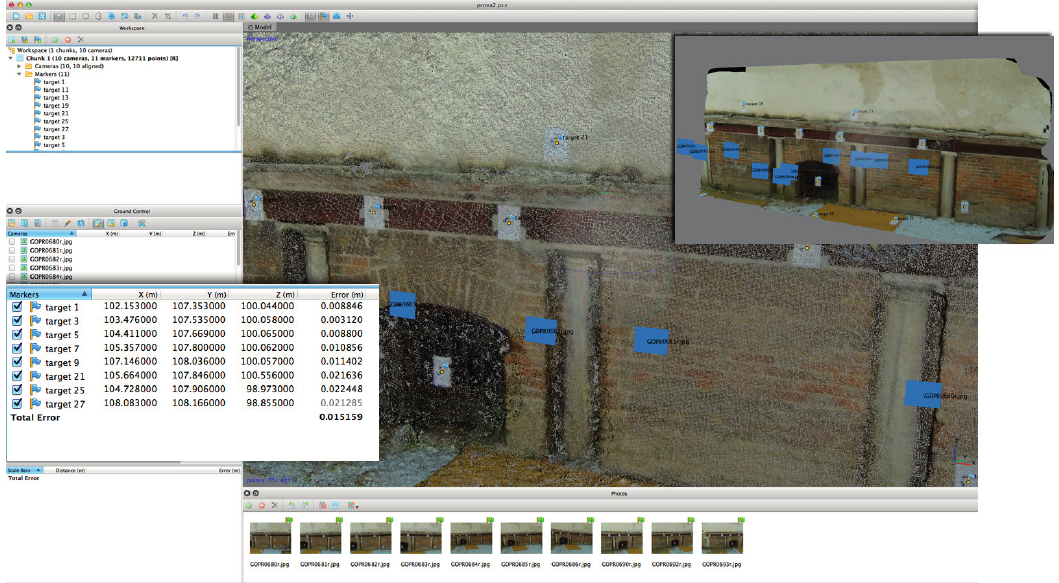
Figure 16. A dense point cloud obtained in Agisoft Photoscan using the GoPro undistorted images. RMS error of collected GCPs is about 0.015 m.